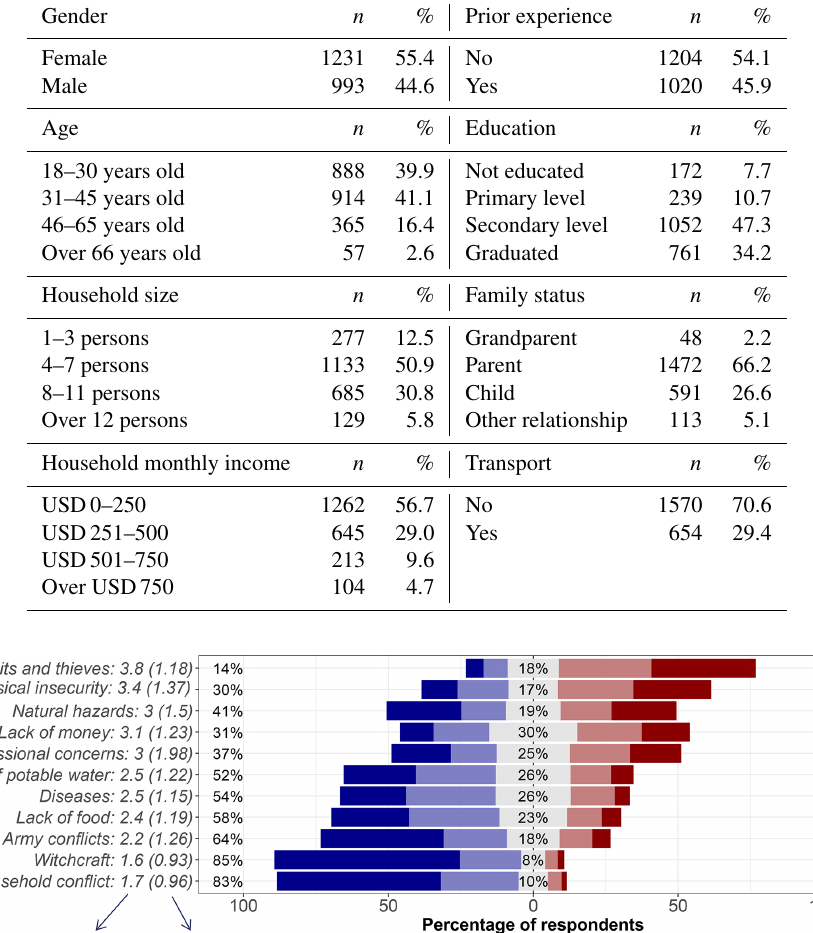
Table 1. Demographic profile of participants.